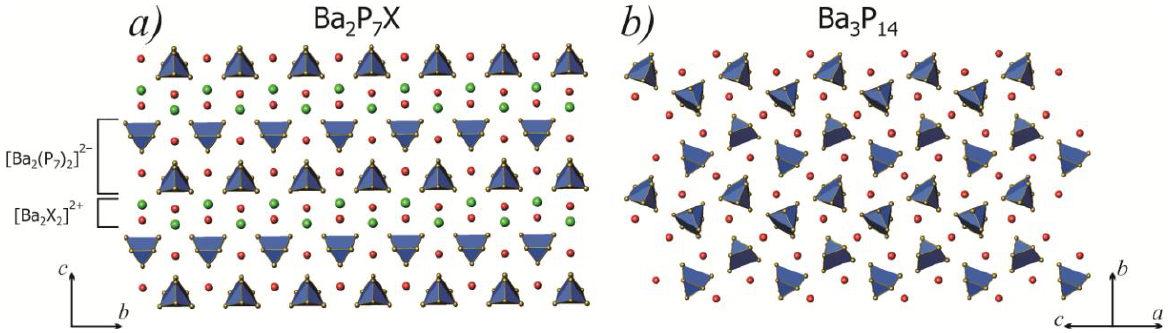
Figure 2. Comparison of the P 73− heptaphosphanortricyclane clusters arrangements in the crystal structures of ( a ) Ba halogen atoms in green; and phosphorous clusters in blue.